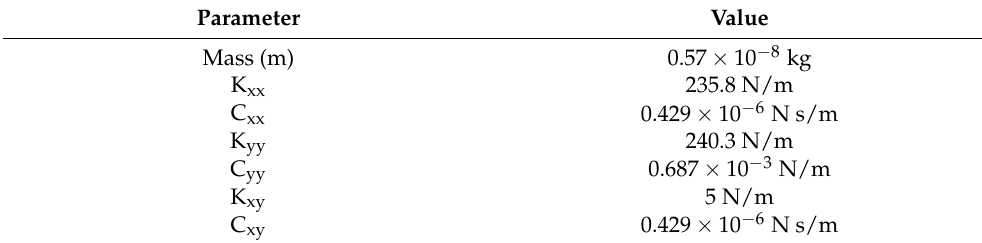
Table 2. MEMS Gyro Parameters.